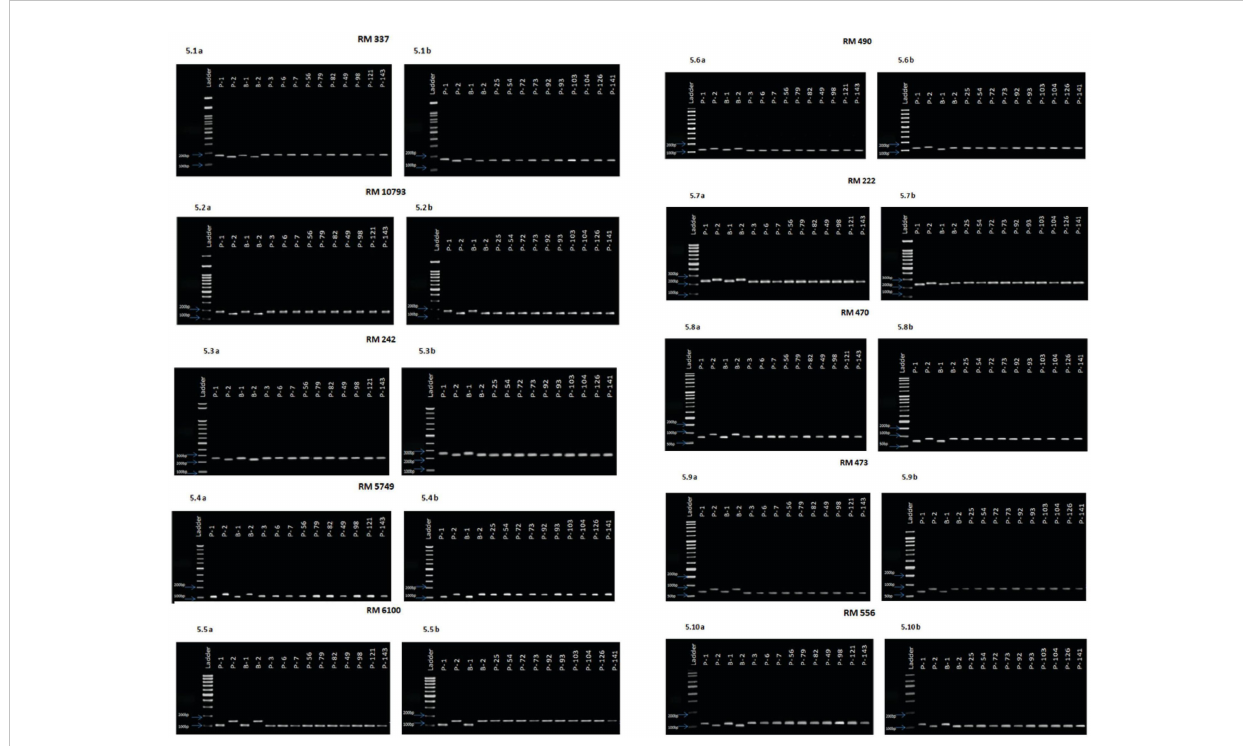
FIGURE 5 (5.1A). Ampli fi cation pattern of SSR markers 100 bp Ladder, P1 — NL 44, P2 — Uma, B1 — Tolerant bulk, B2 — Susceptible bulk, P 3, P 6, P 7, P 56, P 79, P 82, P 49, P 98, P 121, P 143 — Tolerant lines. (5.1B) . Ampli fi cation pattern of SSR markers100 bp Ladder, P1 — NL 44, P2 — Uma, B1 — Tolerant bulk, B2